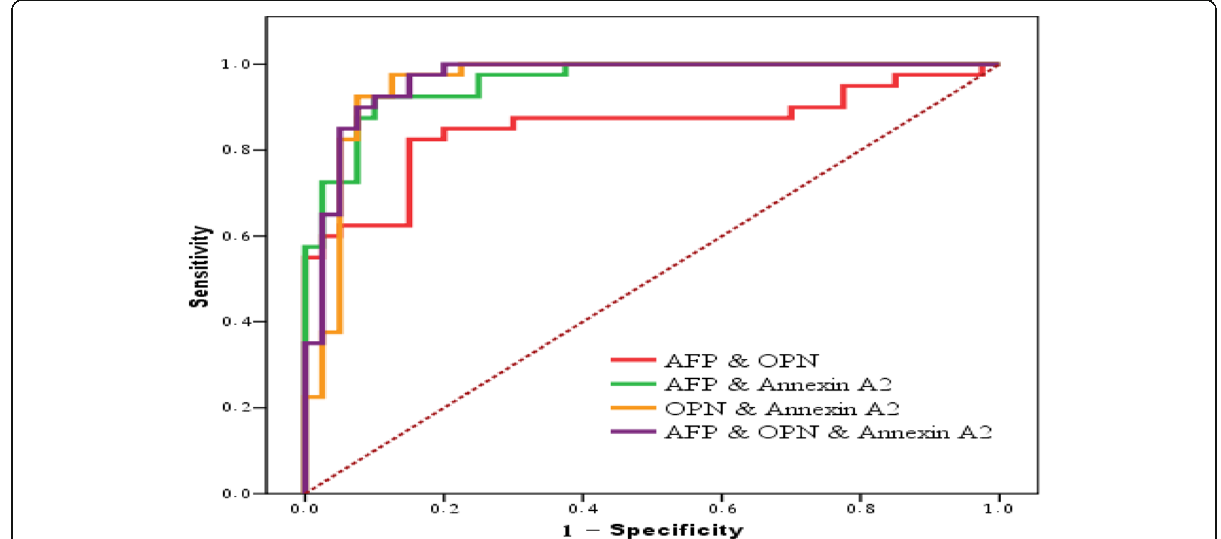
Fig. 3 ROC curve for combination of different tumor markers to diagnose